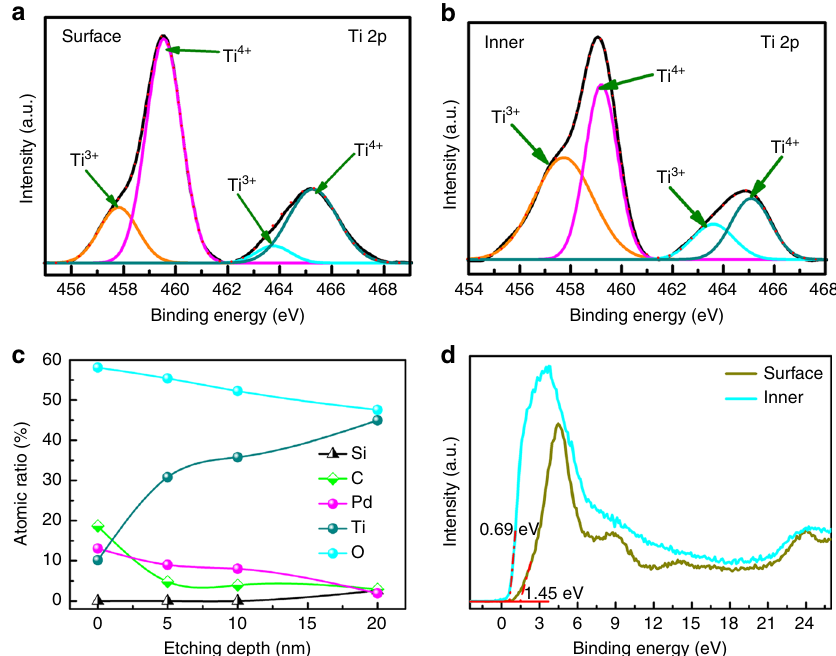
Fig. 4 XPS depth pro fi ling of Pd/b2-TiO 2 /b-Si. a Ti 2p spectrum for the surface of Pd/b2-TiO 2 /b-Si. b Ti 2p spectrum for the inner of Pd/b2-TiO 2 /b-Si after the etching depth of 20 nm. c Elemental depth pro fi le of Pd/b2-TiO 2 /b-Si. d XPS VB spectra of the surface and inner (etching depth of 20 nm) of Pd/ b2-TiO 2 /b-Si. It must be mentioned that the extra C 1 s peak at 284.8 eV is derived from the carbonaceous contaminant absorbed in the sample with an etching depth of 20 nm. The Ti signal increased continuously and became dominant after the etching depth of 20 nm. The Si signal started to be emerged in XPS spectrum. This indicates that the minimum thickness of b-TiO 2 layer for Pd/b2- TiO 2 /b-Si is around 20 nm, in accordance with STEM images. The results also con fi rm that b-Si is fully protected in this case.